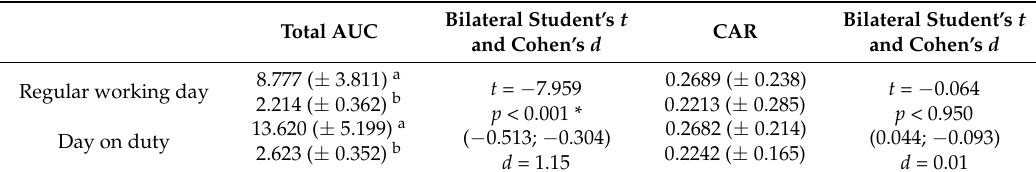
Table 2. Mean area under the curve (AUC) and cortisol awake response (CAR) values for the 35 residents on regular working day versus ED-duty day.